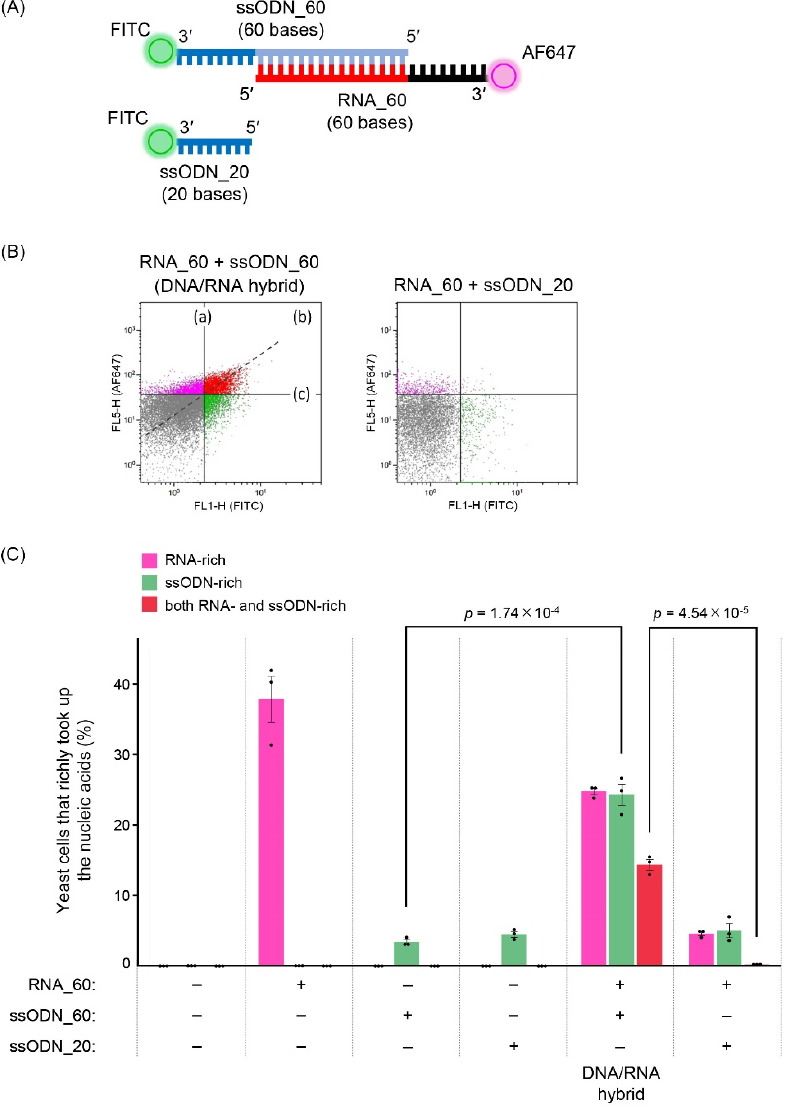
Figure 5. Evaluation of introduction efficiency of DNA/RNA hybrid into yeast cells. ( A ) Schematic of nucleic acids used to evaluate the introduction efficiency. ( B ) Density plots obtained from flow cytometry analysis. ( a ) The ratio of yeast cells that richly took up RNA (RNA-rich yeast cells), ( b ) The ratio of yeast cells that richly took up both RNA and ssODN (both RNA- and ssODN-rich yeast cells), and ( c ) The ratio of yeast cells that richly took up ssODN (ssODN-rich yeast cells). The data shown are representative of three independent experiments. ( C ) The introduction efficiency was evaluated using flow cytometry. Values indicate the ratio of RNA-, ssODN- or both RNA- and ssODN-rich yeast cells. Error bars represent the SEM of three biological replicates starting from independent electroporation of nucleic acid solutions. Points represent each experimental data set. A two-tailed Student’s t -test was used to assess the statistical significance.